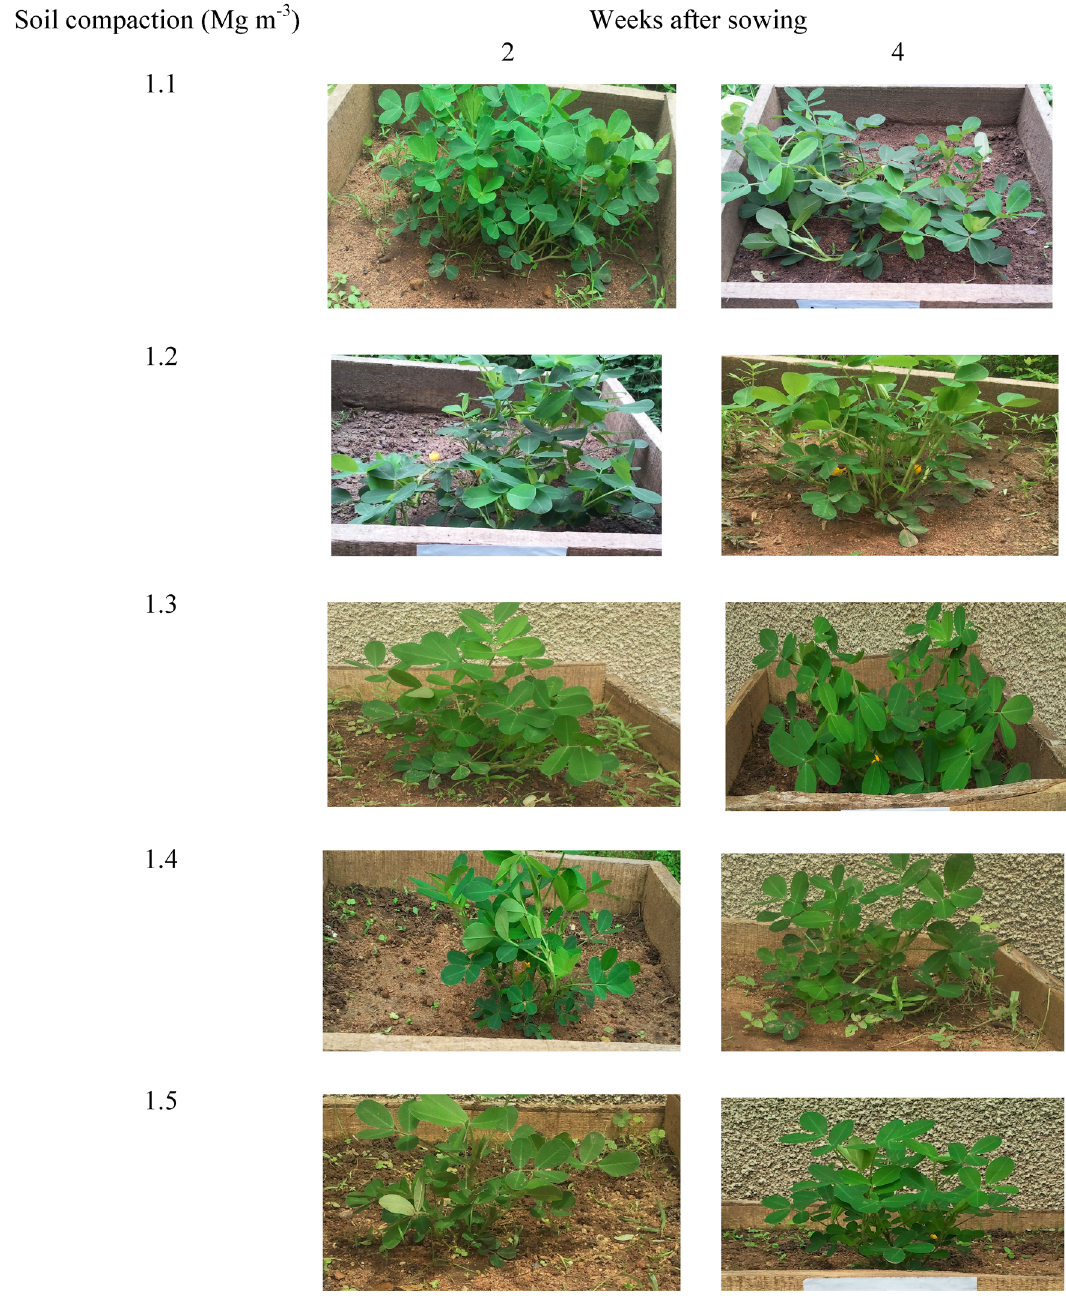
Figure 1: Groundnut plants as a ff ected by soil compaction at 2 and 4 weeks after